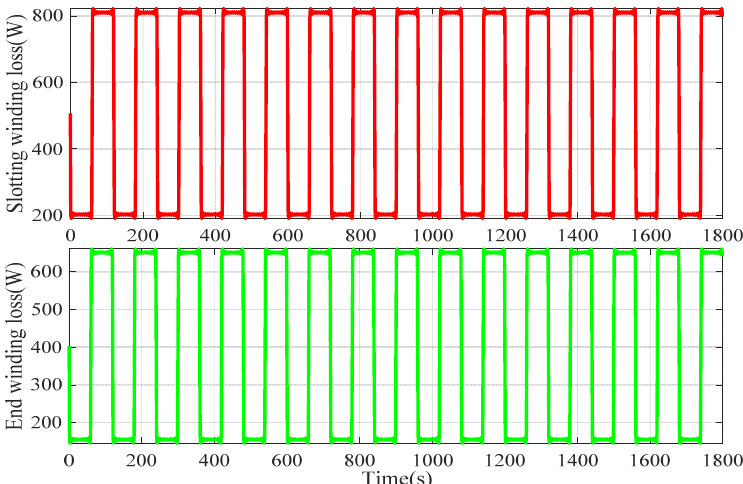
Figure 11. Slotting and end winding losses in the form of rectangular wave load.